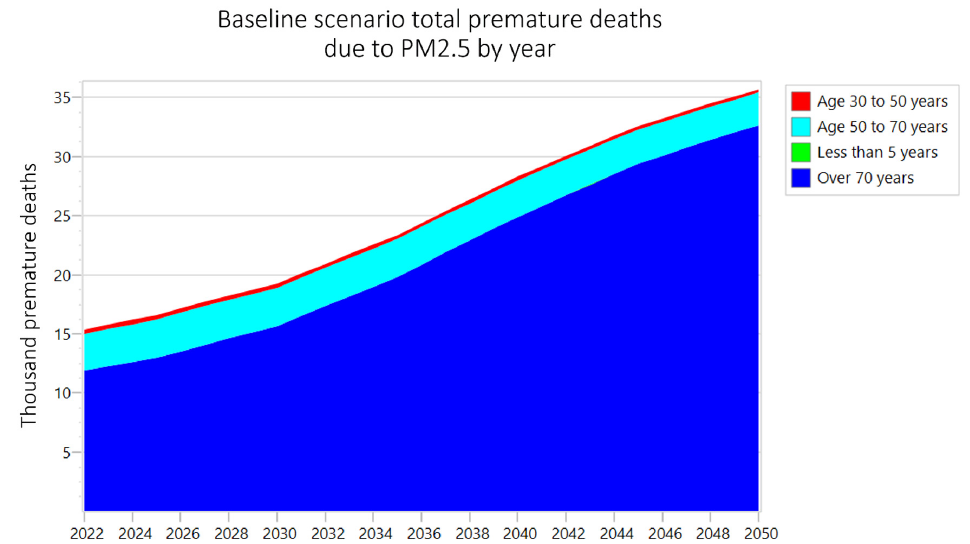
Figure 4. Projected total premature deaths by age group due to PM2.5 in baseline scenario.